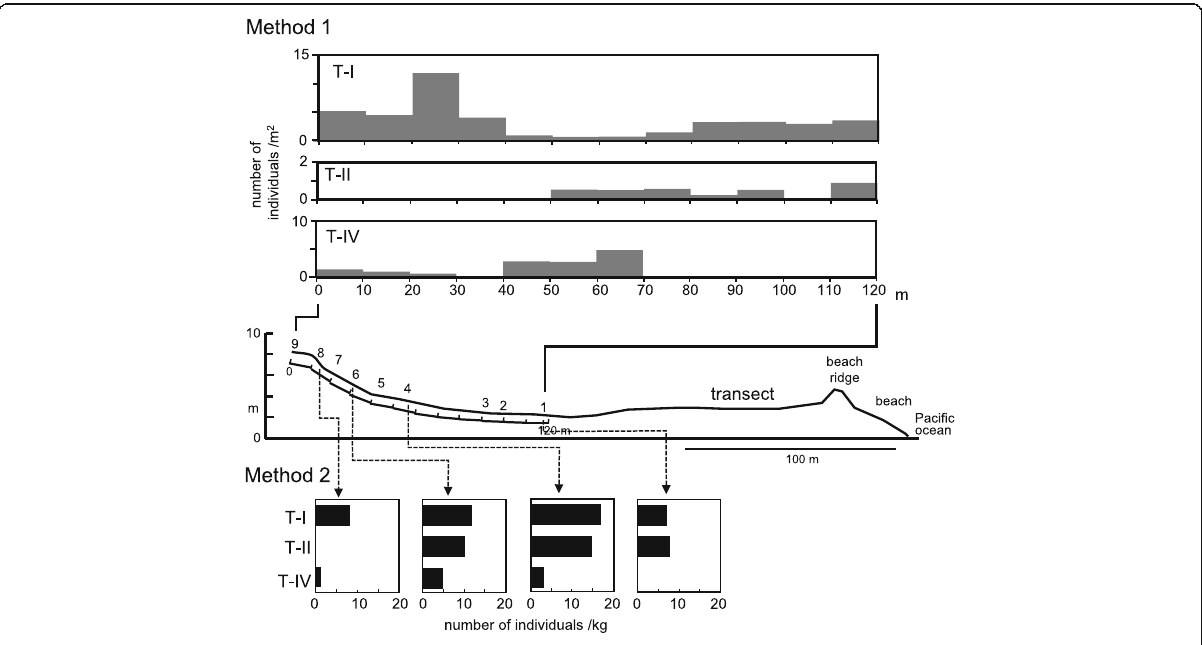
Fig. 6 Molluscan abundances in the tsunami deposits obtained in a trench using methods 1 and